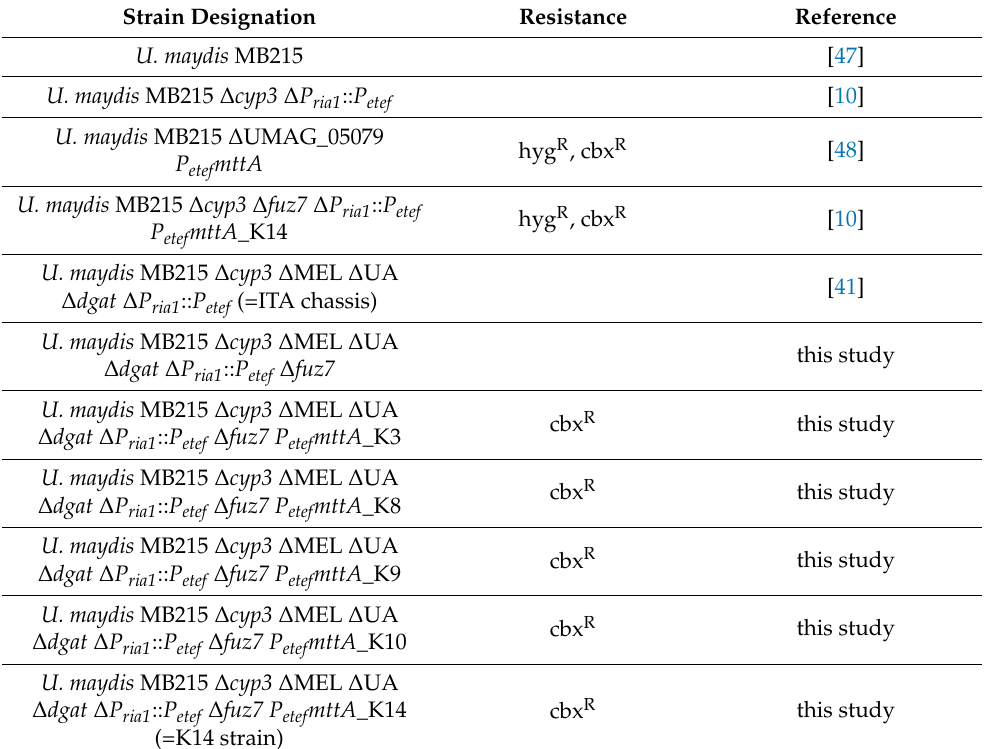
Table 1. U. maydis MB215 strains used in this